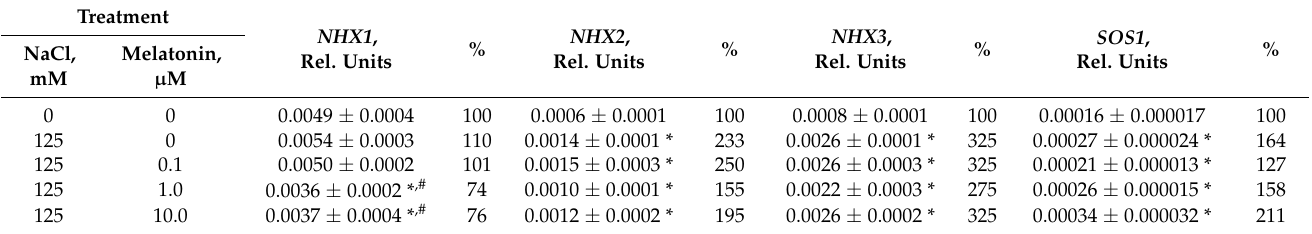
Table 4. Influence of melatonin on the levels of transcripts of genes encoding Na + /H + antiporters of the tonoplast ( NHX1 to NHX3 ) and plasmalemma ( SOS1 ) in Solanum tuberosum plants under saline